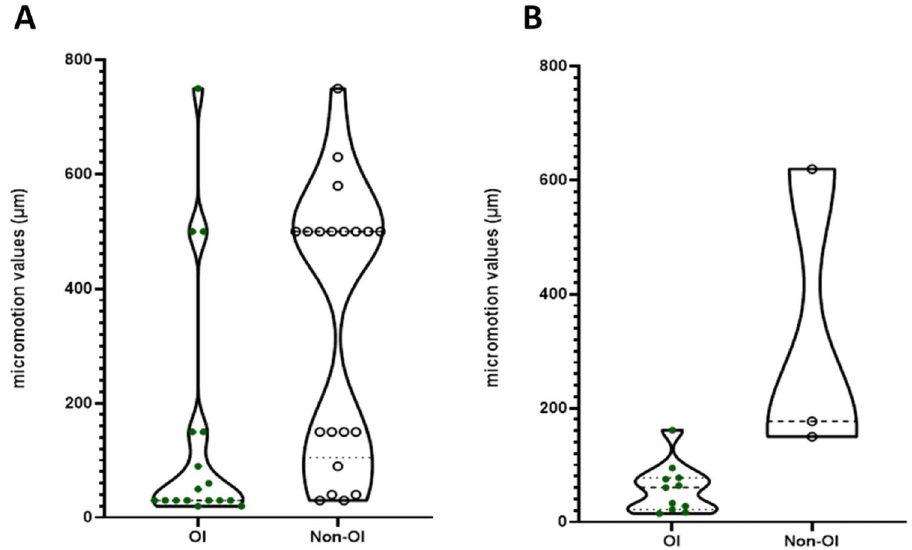
Figure 3. ( A ) Applied values of micromotion in osseointegrated (OI, n = 17) and non-osseointegrated (Non-OI, n = 20) groups for the animal studies. Mann Whitney p value = 0.001 **. ( B ) Measured values of micromotion in OI (n = 11) and non-OI (n = 3) for the animal studies. Mann Whitney p value = 0.003